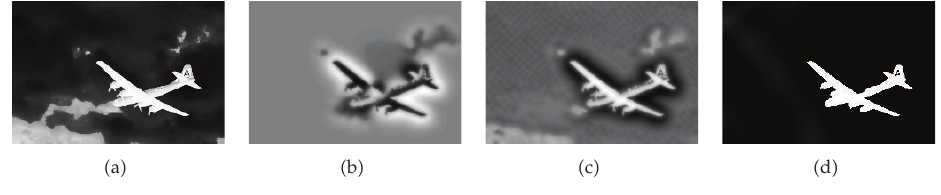
Figure 3: Comparison of the final level set function φ with di ff erent models for the airplane image from Figure 2. The final φ obtained by the CV model, the LBF model, the LGIF model, and the proposed model is shown in (cid:6) a (cid:7) – (cid:6) d (cid:7) , respectively.